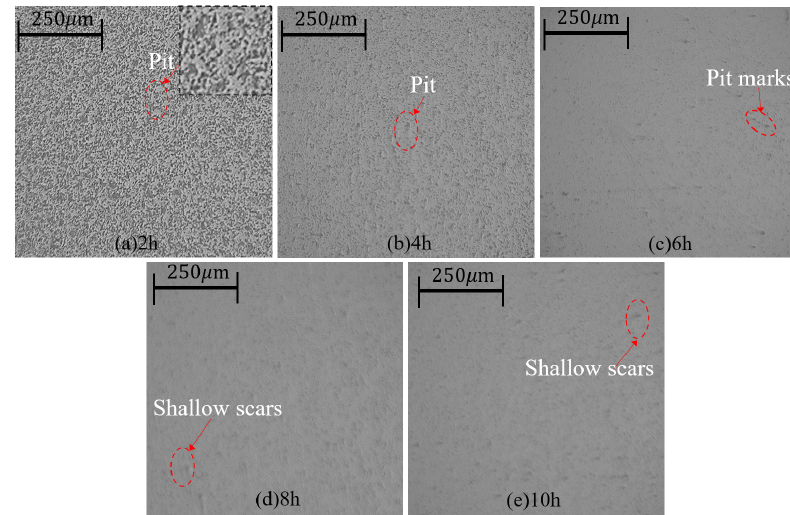
Figure 12. Microscopic appearance of samples at different